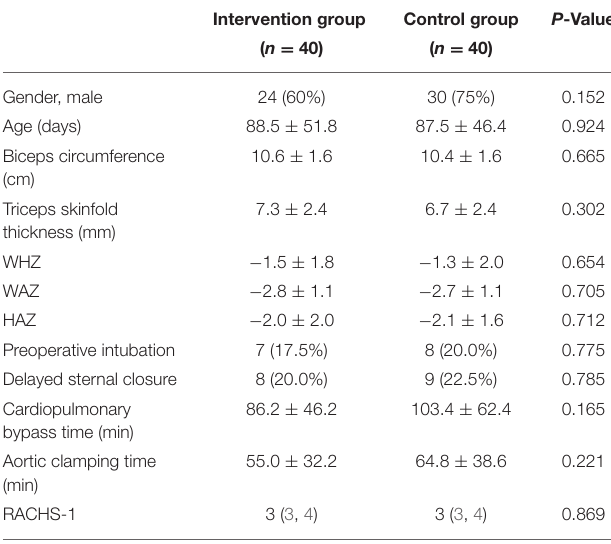
TABLE 1 | Baseline characteristics of the participants.